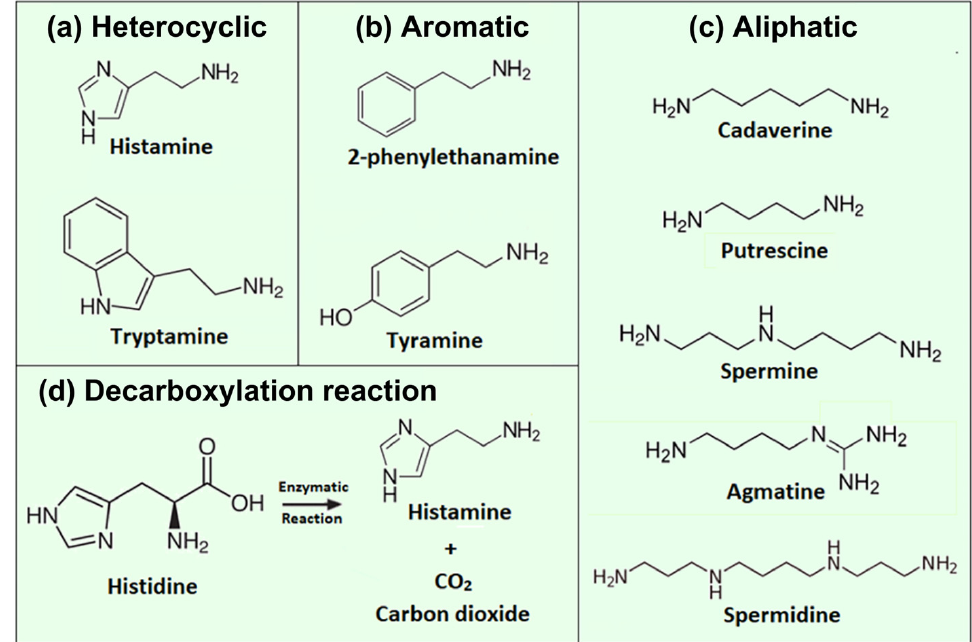
Figure 1. Chemical structures of important biogenic amines playing a role in food safety, including ( a ) heterocyclic, ( b ) aromatic, and ( c ) aliphatic examples. Panel ( d ) shows schematically the enzymatic decomposition of its parent compound, the amino acid histidine, into histamine and carbon dioxide. Due to its structural similarity, histidine is frequently used as a competitor molecule to assess the selectivity of natural and synthetic histamine receptors.